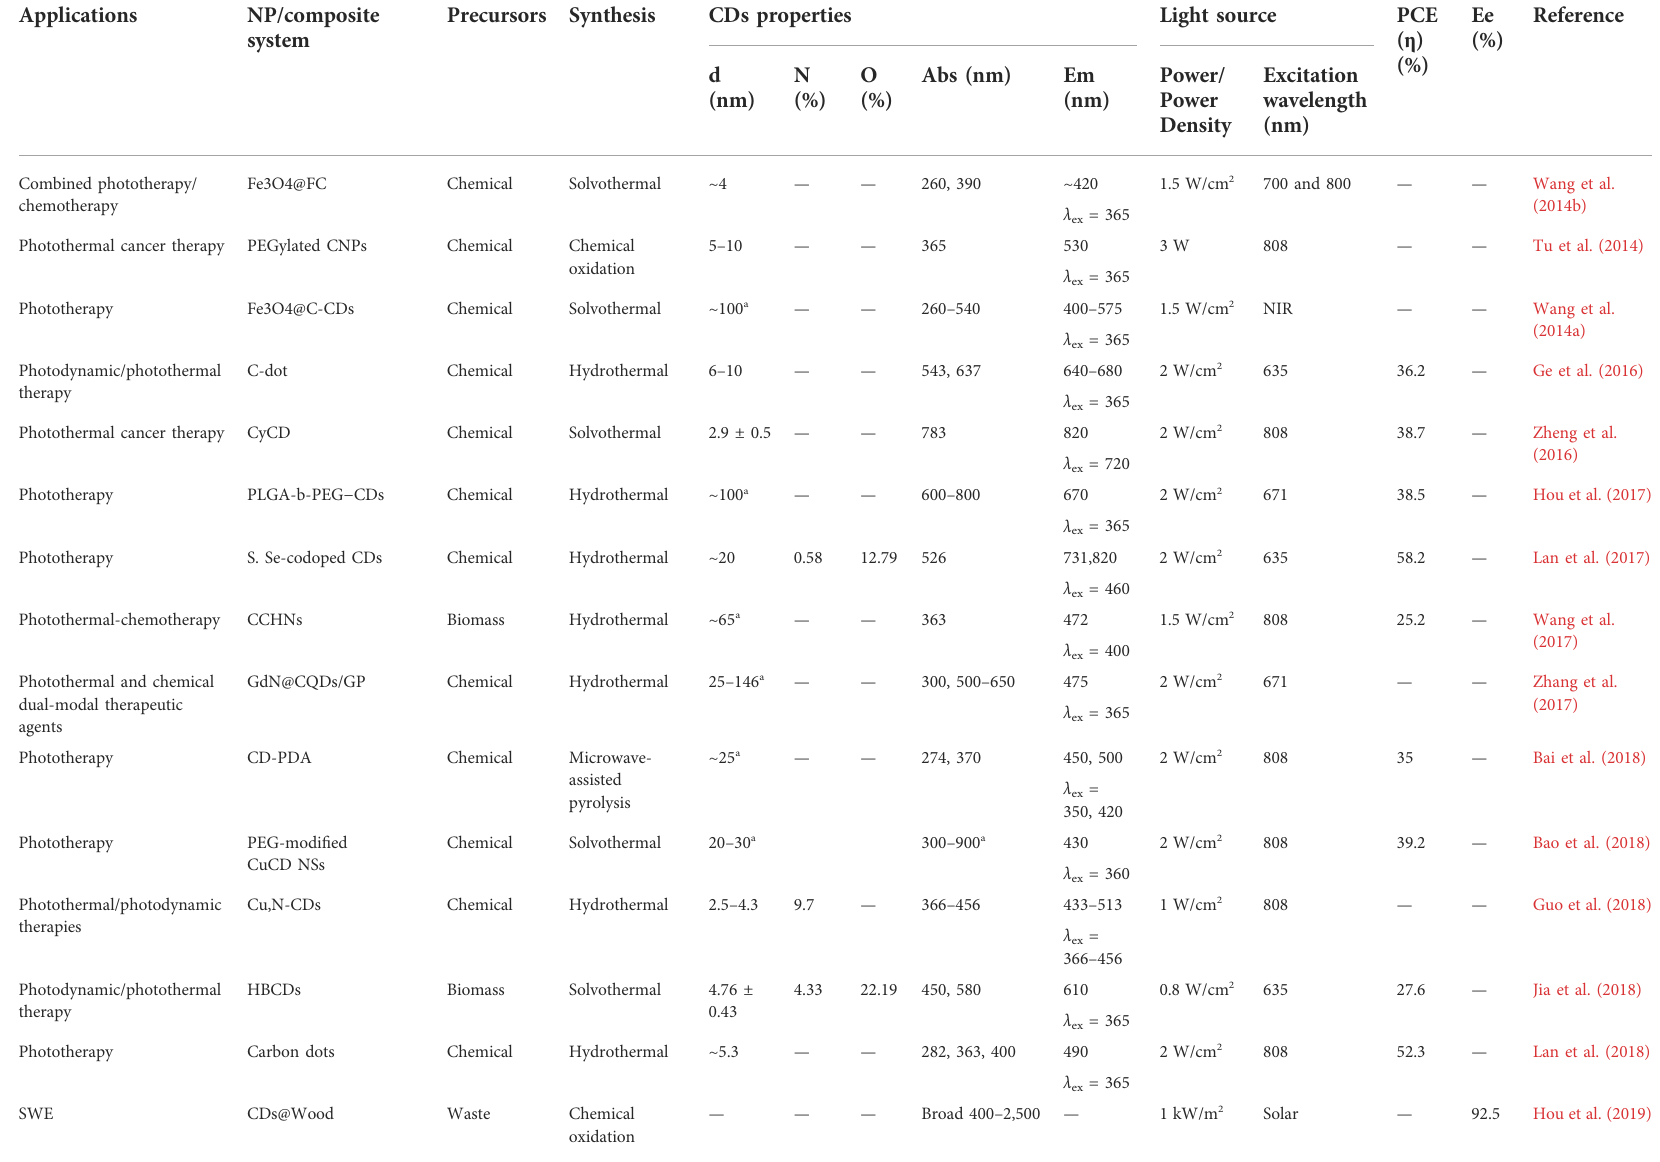
TABLE 1 Photothermal application, synthesis protocol, properties, and PCE of carbon